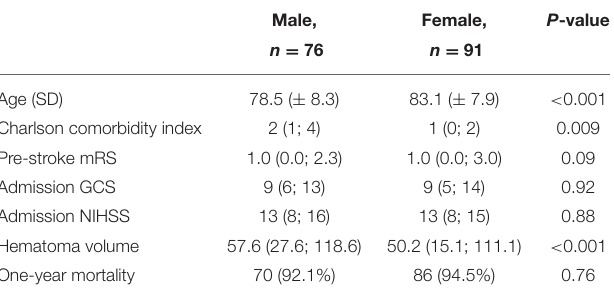
TABLE 3 | Patients with OAC-related ICH given DNR orders within